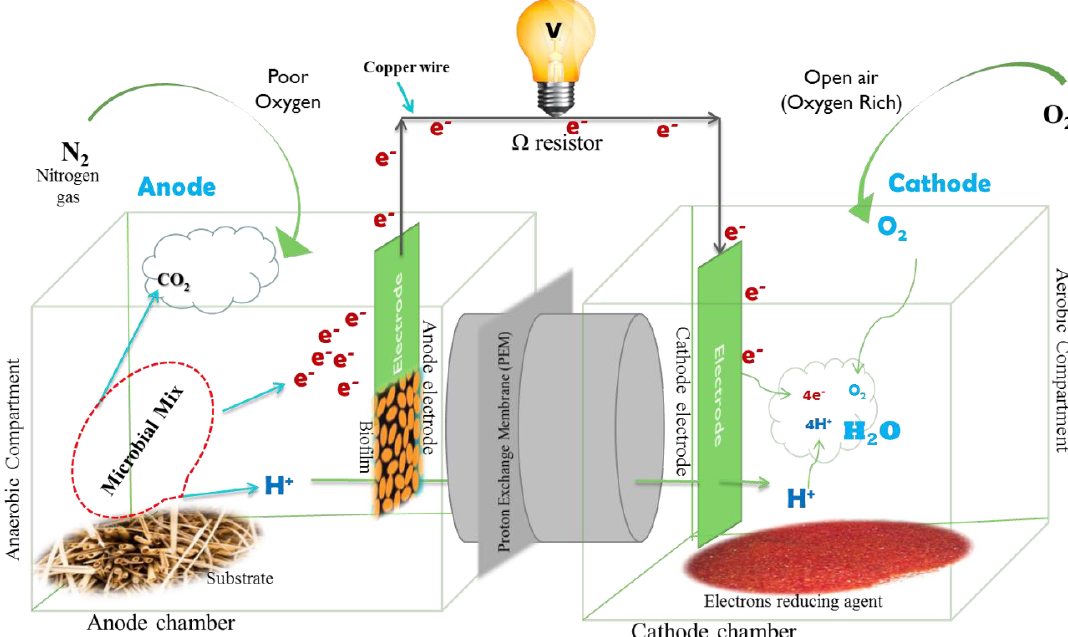
Figure 2. Major elements of an microbial fuel cell (MFC) reactor: 1. A proton exchange membrane separating the two chambers; 2. Anode chamber (anaerobic conditions); 3. Cathode chamber (aerobic conditions); 4. Substrate for microorganisms metabolism; 5. Pure or mixed bacterial cultures (a) and